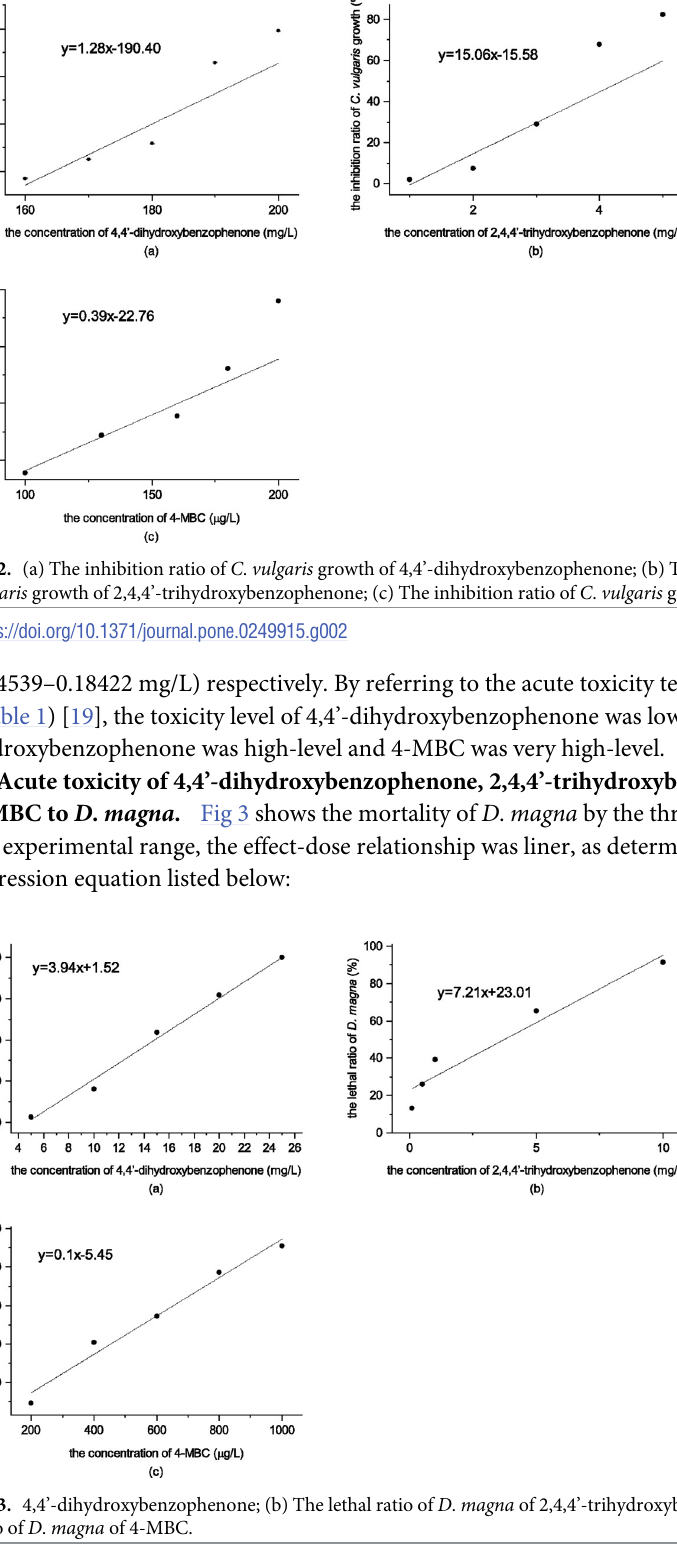
Fig 3. 4,4’-dihydroxybenzophenone; (b) The lethal ratio of D . magna of 2,4,4’-trihydroxybenzophenone; (c) The lethal ratio of D . magna of 4-MBC.